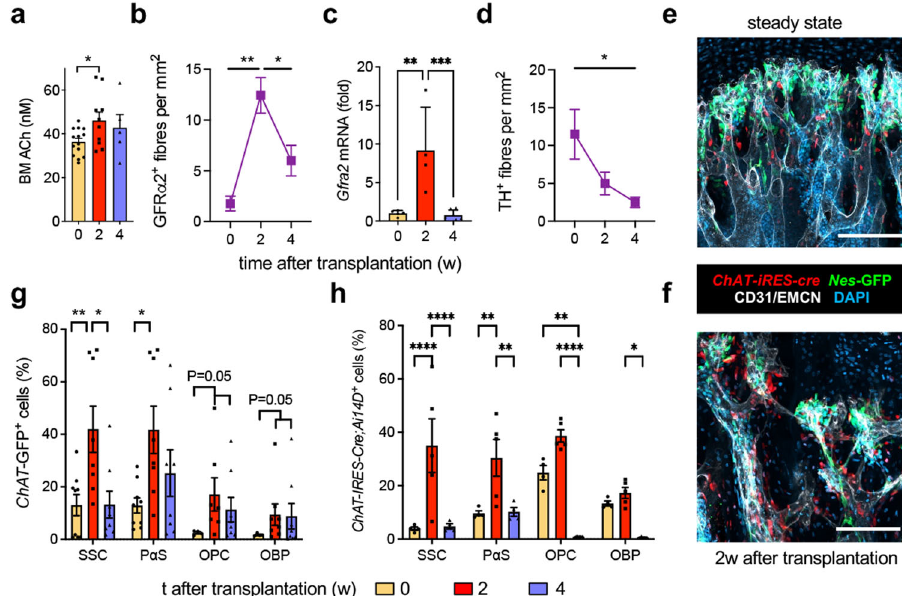
Fig. 1 Cholinergic expansion during haematopoietic regeneration. a , c Acetylcholine (ACh) content ( a ; N = 5,9,14; P = 0.03) and Gfra2 mRNA expression ( c ; N = 5,4,7; P = 0.002,0.0008) in endosteal BM before or 2 – 4 weeks after transplantation. b , d Density of ( b ) cholinergic (GFR α 2 + ; N = 4,5,9; P = 0.003,0.02) or ( d ) noradrenergic (tyrosine hydroxylase, TH + ; N = 4,8,6; P = 0.01) genetically marked nerve fi bres in Wnt1-Cre2;Ai14D mice. e , f Representative genetic tracing showing the expansion of cholinergic stromal cells (red) adjacent to Nes -GFP + BMSCs (green) associated with CD31 + or endomucin (EMCN) + blood vessels (white) near the growth plate of ChAT-IRES-Cre;Ai14D;Nes-GFP tibias ( N = 3). Nuclei are counterstained with DAPI (blue). Scale, 50 μ m. g , h Transient expansion of endosteal BM cholinergic PDGFR α + Sca1 − skeletal stem cells (SSC), PDGFR α + Sca1 + (P α S)